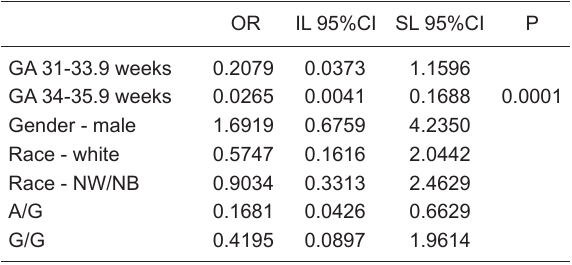
Table 5. Odds ratio of the A/G 9306